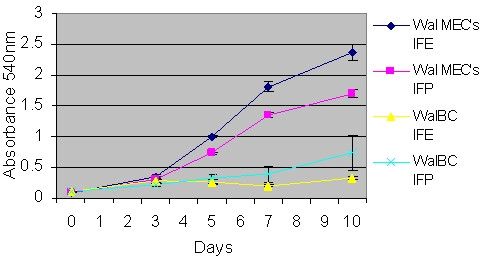
Comparative analysis of proliferation rates between WalBC and wallaby MEC's. Cells were grown for 10 days in the presence of insulin (I), cortisol (F) and prolactin (P) or I, P and epidermal growth factor, EGF (E). Wal MEC's responded to the presence of EGF (P = 0.0041, 95% confidence interval, t = 8.0113, df = 3).